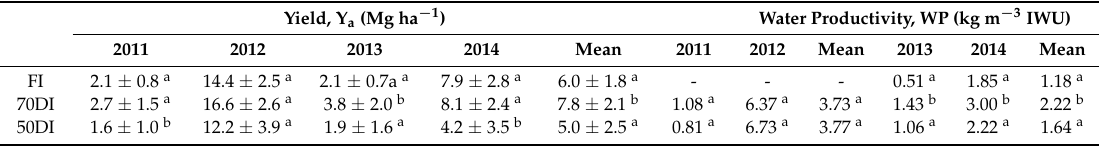
Table 6. Summary of yield (Y a ) and water productivity (WP) obtained for all years and